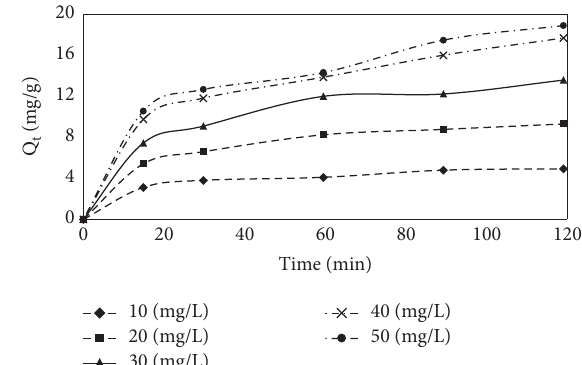
Figure 10: Kinetics adsorption of Cr(VI) from aqueous solution using WM adsorbent at pH � 2, time � 120min, and adsorbent dose W �